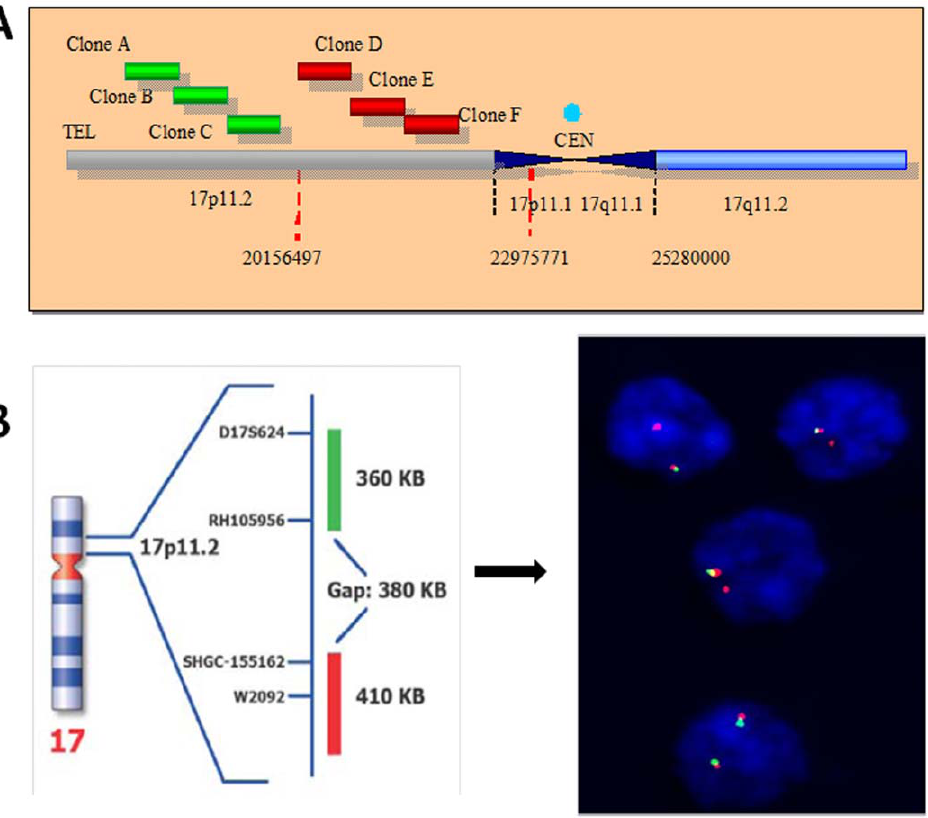
Figure 1. Schematic representation of the chromosome 17p11.2 dual color Break Apart probe combination designed and used for iFISH analysis of this chromosomal region in sCRC. Panel A describes the probe design for which three different clones (A, B and C) directly- labelled with PlatinumBright495 (green signal) and that hybridize to the telomeric part of the 20,156,497 bp region were combined with another three clones (clones D, E and F) directly labelled with PlatinumBright550 and that correspond to sequences harboured centromerically to 20,156,497 bp (red signal), and were produced. The 17p11.2 Break Apart DNA Probe finally consisted of a dual-color assay to detect breakpoints at 17p11.2 using the combination of these 6 fluorescently labelled clones. A positive breakpoint at chromosome 17p11.2 was defined when one or two red/green or yellow fusion signals split into two separate red and green signals. Only red and green signals which were more than one signal diameter apart from each other were counted as reflecting a chromosome break, since based on the probe design a gap of 380 KB exists between the two sets of probes corresponding to the green and the red signals, respectively; two fusion signals identify the two normal chromosomes 17 as illustrated for the lower nuclei shown in panel B. Loss of a green signal in the presence of a single red signal and a fusion signal was interpreted as associated with del(17p) with a 17p11.2 breakpoint (e.g; three upper nuclei in panel B).